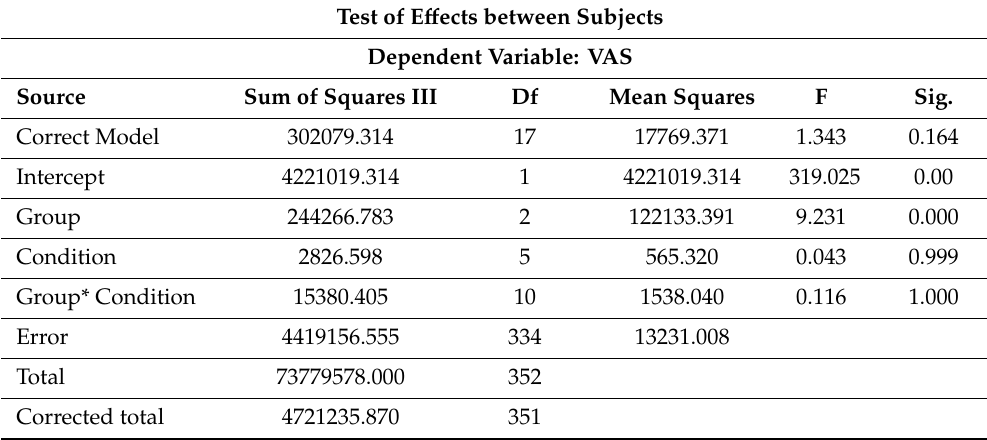
Table 1. Two-way Analysis of Variance (ANOVA) results.